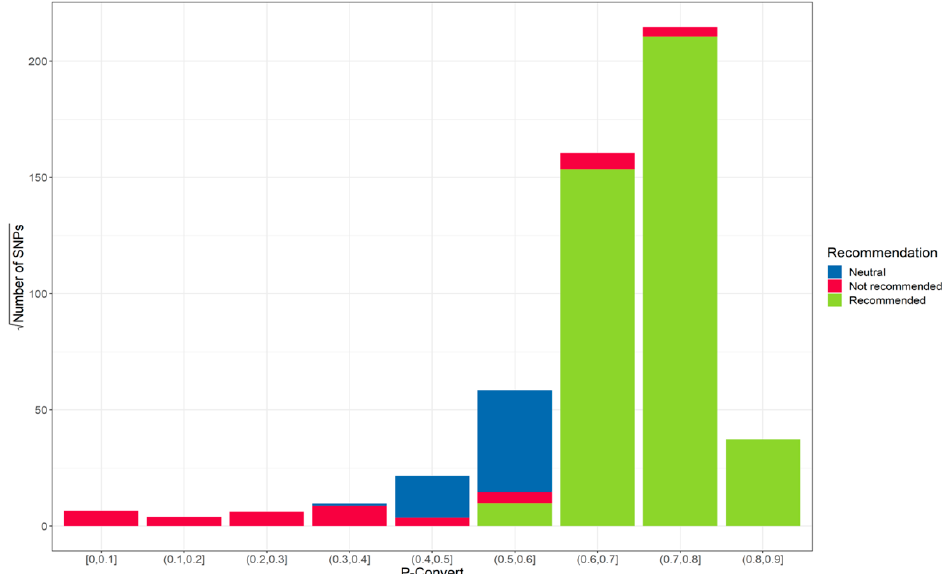
Figure 2. Distribution of the square root of the number of SNPs based on p-convert score and colored by recommendation from Affymetrix in-silico analyses. (P-convert = Probability of conversion based on the best selected strand of the probe sequence.)